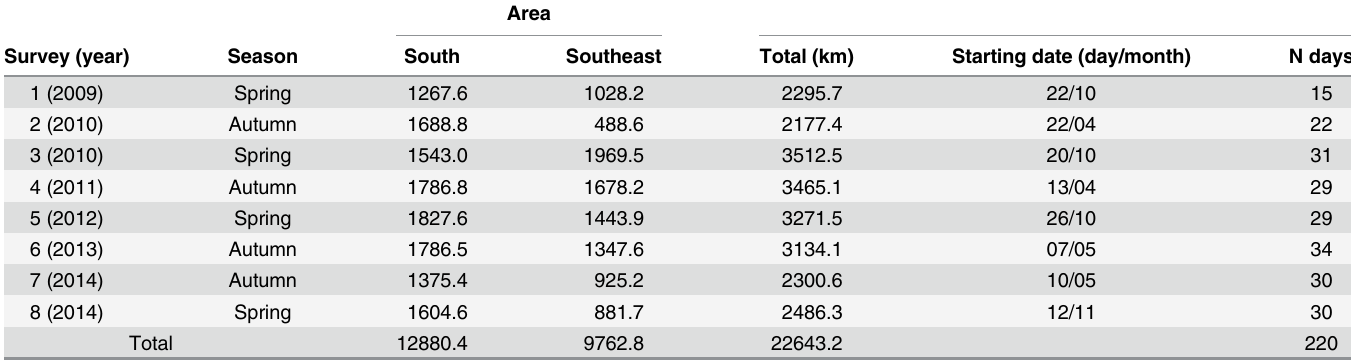
Table 1. Summary of the survey effort (km) for each year and season in south and southeast Brazil between 2009 and